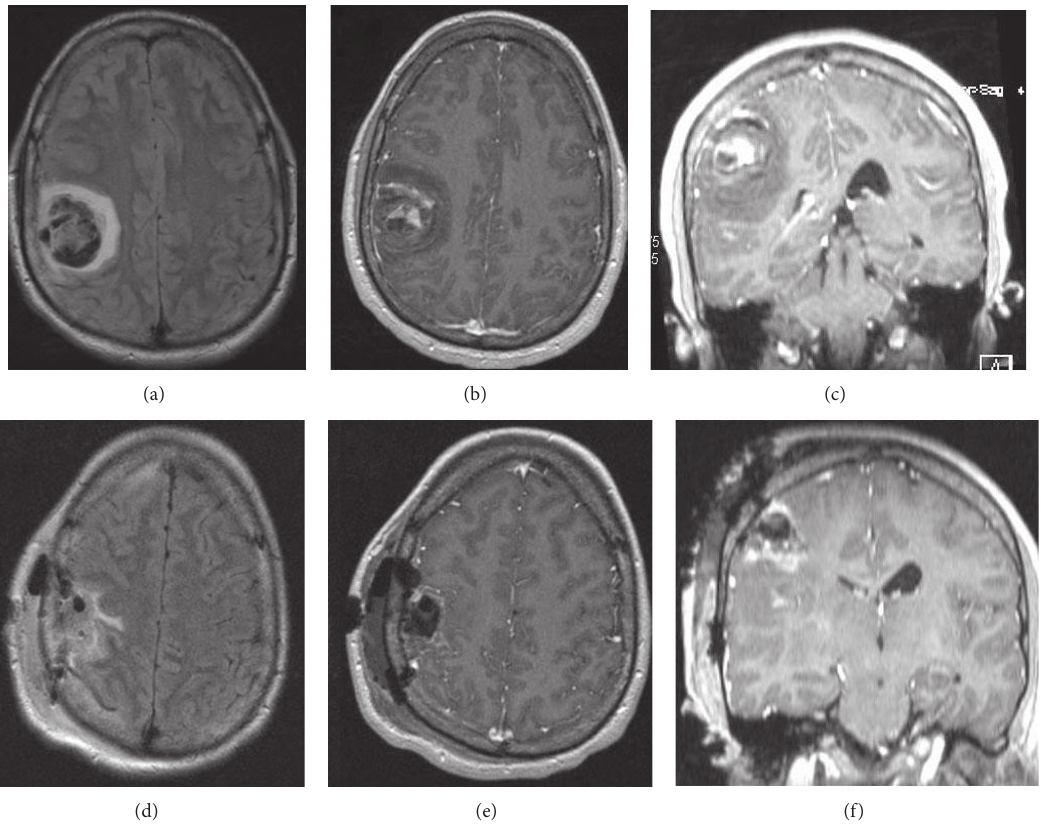
Figure 1: Preoperative axial flair MRI (a) and axial/coronal T1 MRI ((b),(c)) showing a large hemorrhagic infiltrative mass at the right fronto- parietal region. Postoperative axial flair MRI (d) and axial/coronal T1 MRI ((e),(f)) showing a 1cm persistent tumor within the surgical